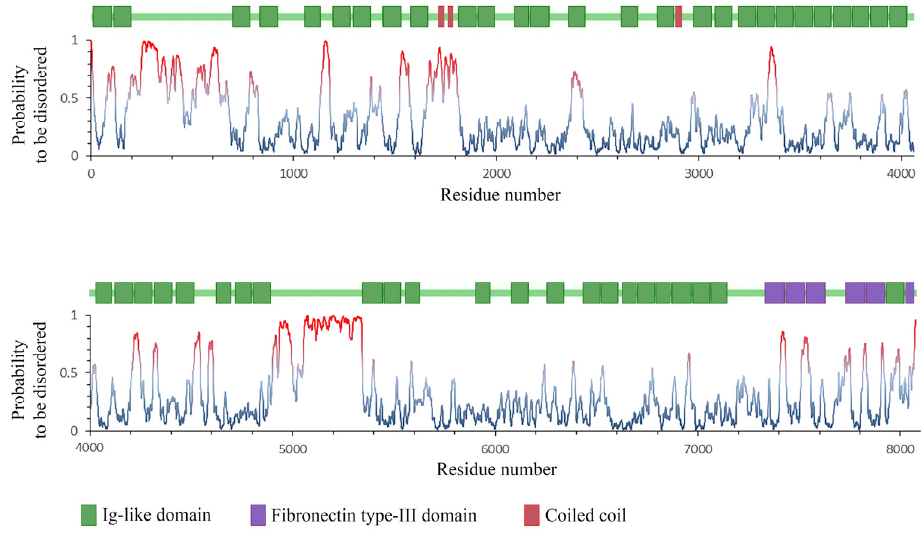
Figure 8. Titin-chicken domain structure schematic aligned with the protein disorder prediction plots by the IsUnstruct program [44]. Probabilities of ≥ 0.5 mean a